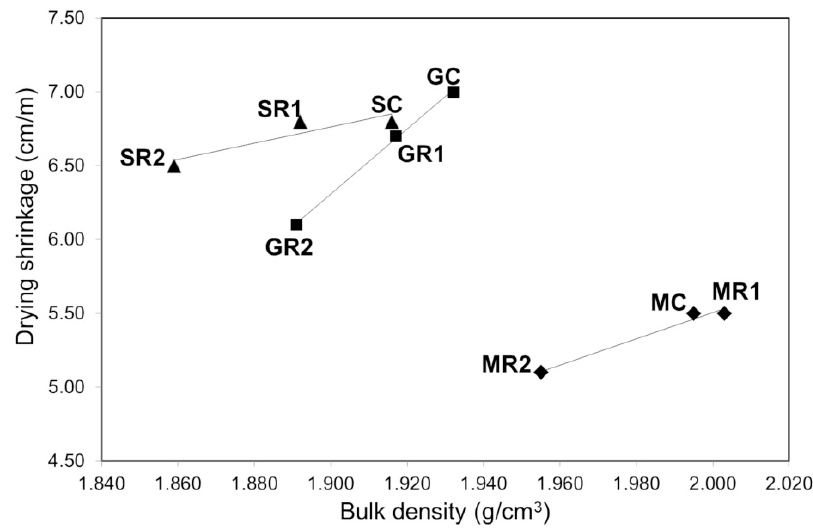
Figure 1. Correlation between bulk density versus drying shrinkage of unfired products. Table 4. Firing behavior of batches. 3.3. Technological Behaviour after Firing Tables 4 and 5 present the results related to the firing behavior of ceramics batches.